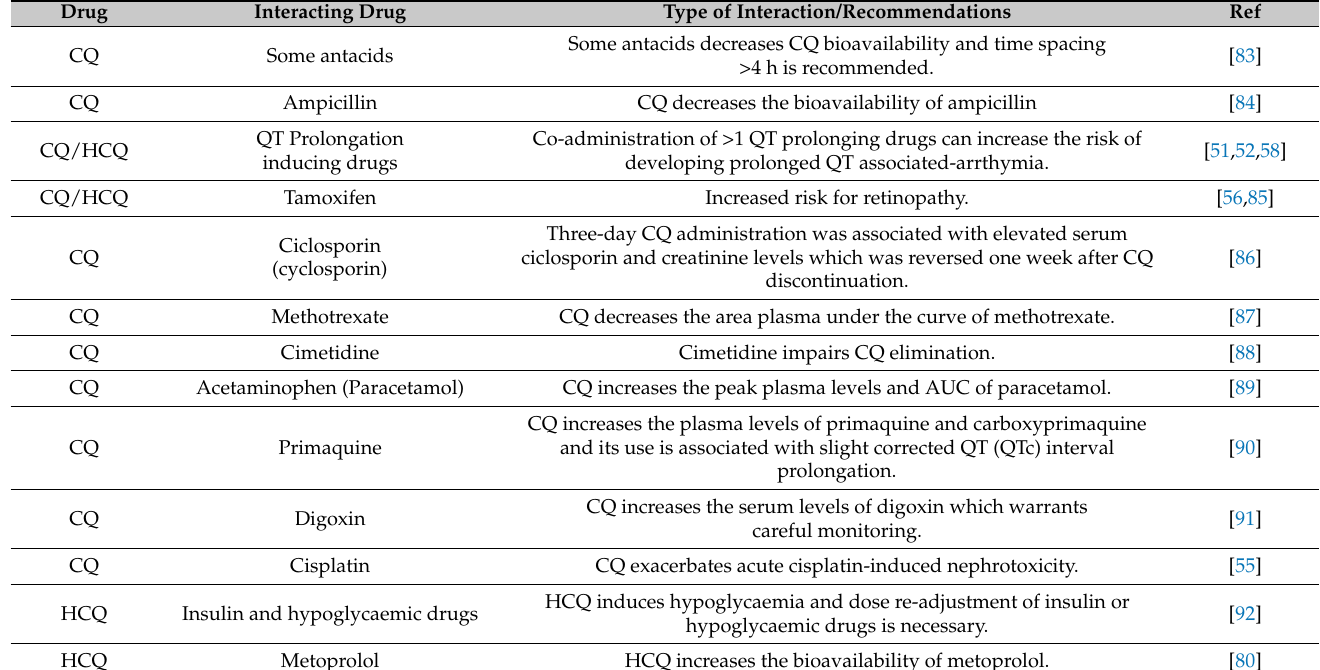
Table 2. Known and potential drug–drug interactions of chloroquine (CQ) and hydroxychloroquine